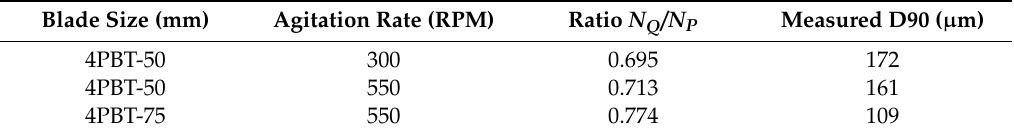
Table 1. Summary of mixing conditions and resulting D90 for lab-scale experiments.